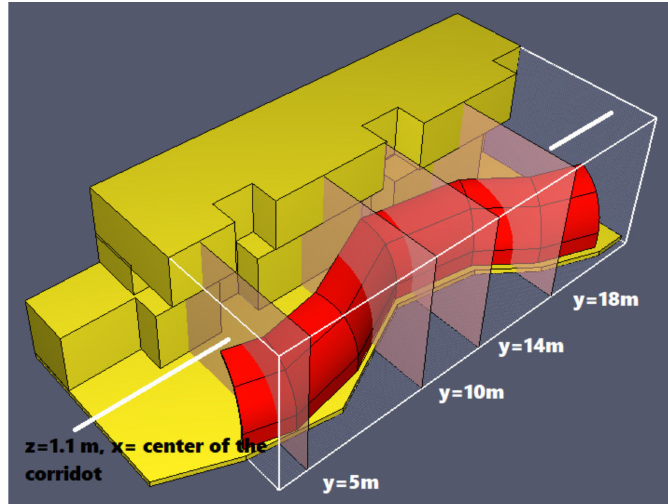
Figure 20. Geometrical